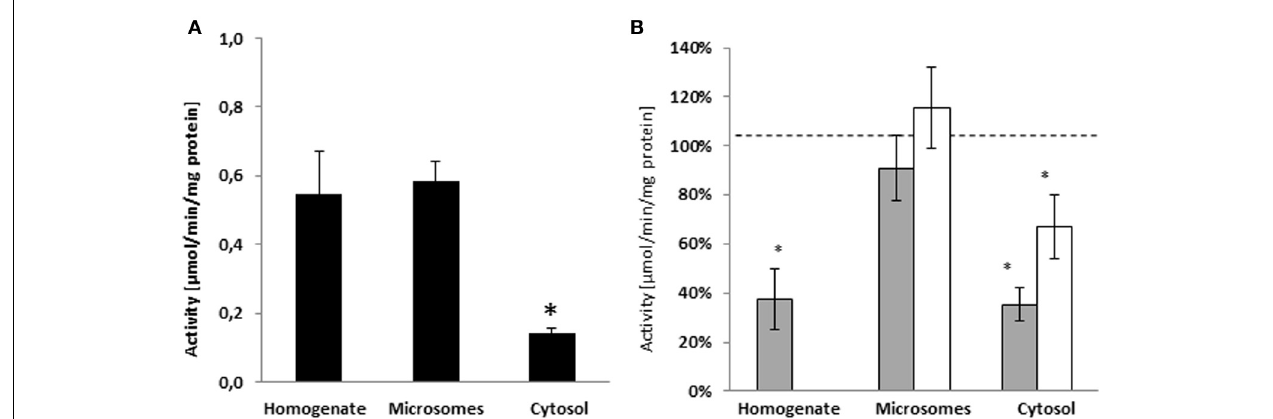
FIGURE 1 | (A) Activity of sub-cellular fractions of human liver from Caucasian donors ( n = 5) on the hydrolysis of nandrolone decanoate. The hydrolysis of nandrolone decanoate was lower in the cytosols as compared to